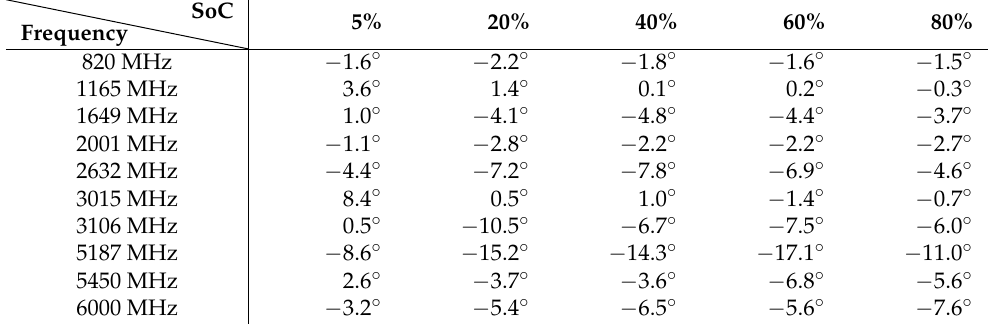
Table 2. Change in phase shift (in degrees) with SoC at select frequencies using a baseline of 95%